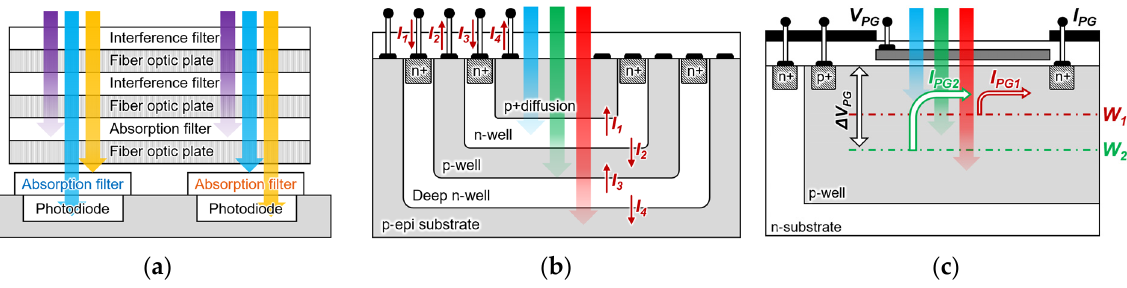
Figure 1. Principle schematic of the on-chip fluorescence detection device. ( a ) Description of what is contained in the first panel; ( b ) CMOS Buried quad p-n Junction photodetector; ( c ) filter-free fluorescence sensor.